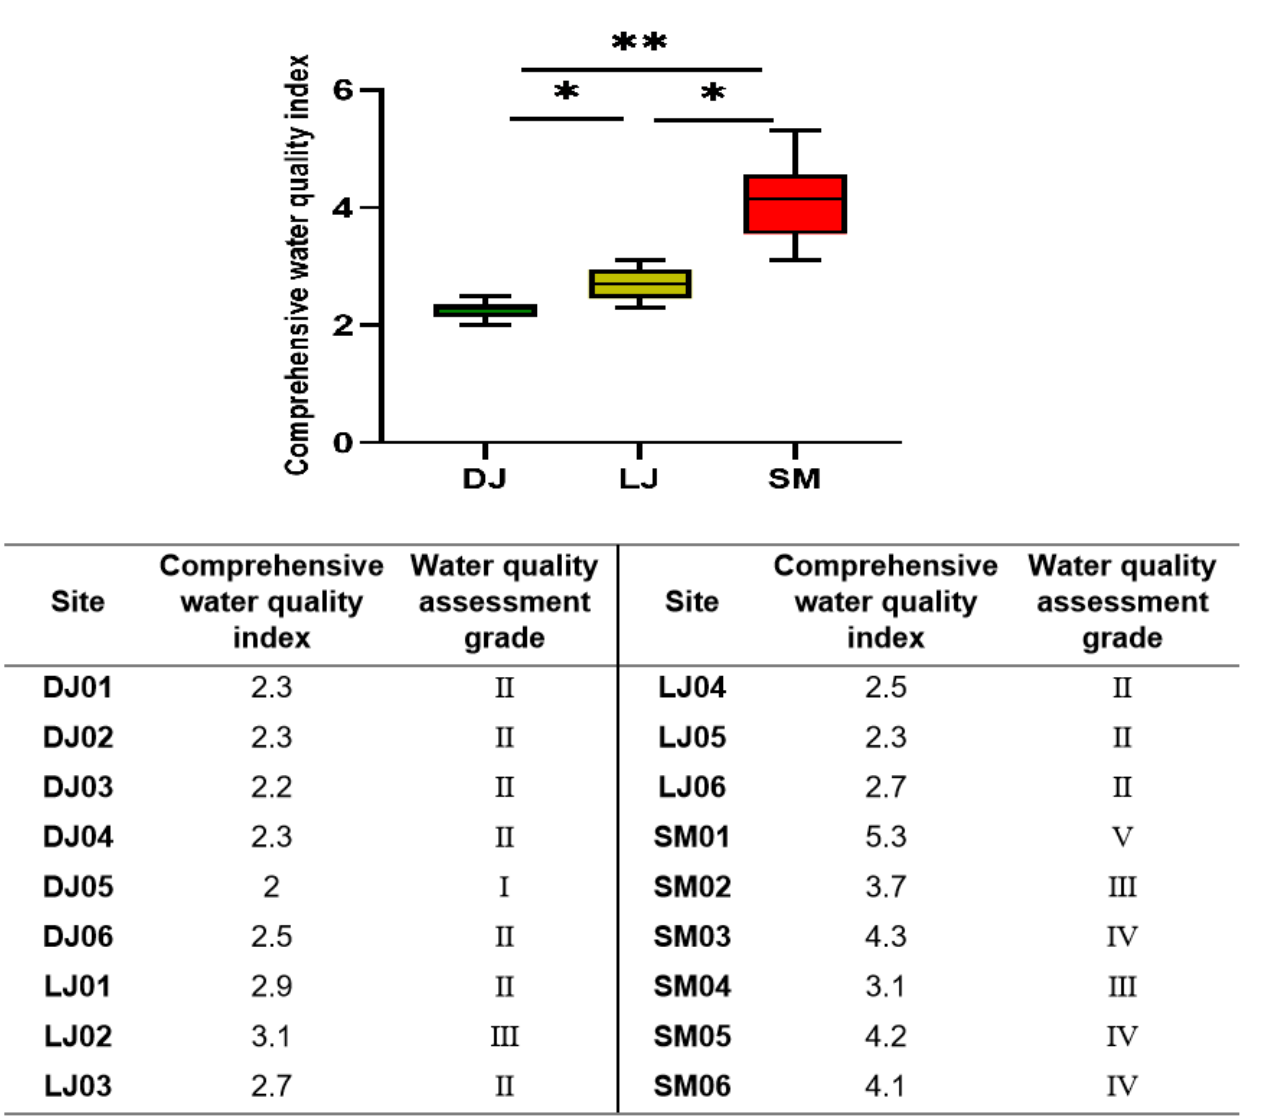
Figure 4. Results of the water quality evaluation, based on the comprehensive water quality index in Dongjiang River. “*” indicates significant at the 0.05 level “**” indicates significant at the 0.01 level.